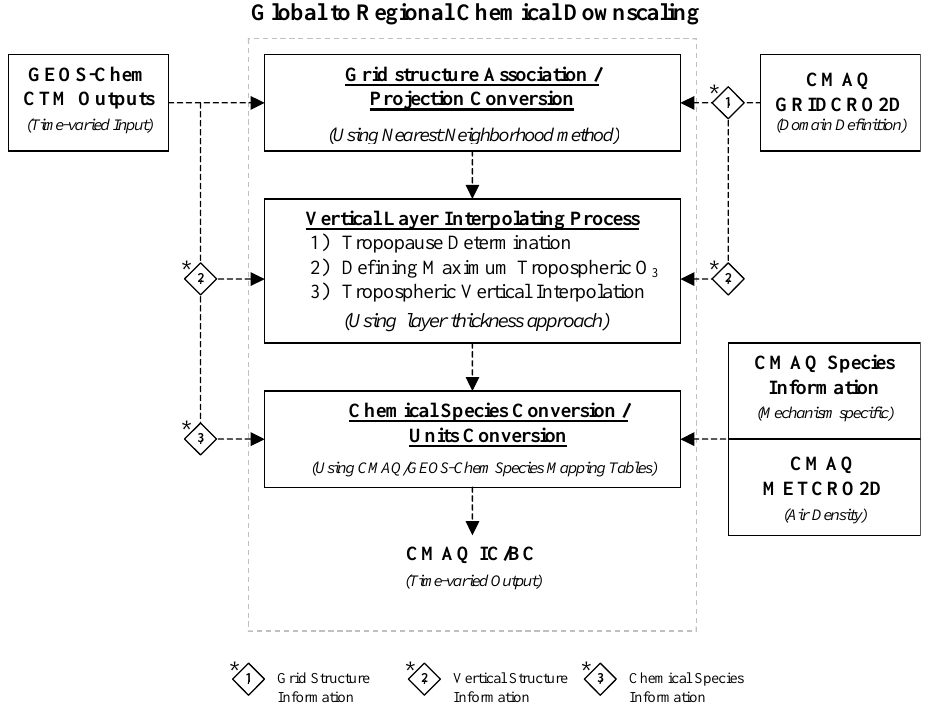
Fig. 4. Systematic flowchart of global to regional chemical downscaling